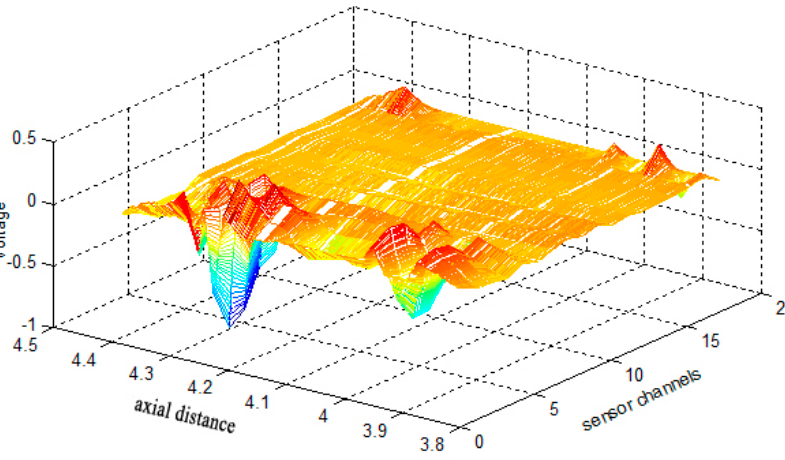
Figure 8. Image of a defect signal with system noise suppressed by means of the proposed HHT and CSWF algorithm (raw data obtained from Figure 5b).